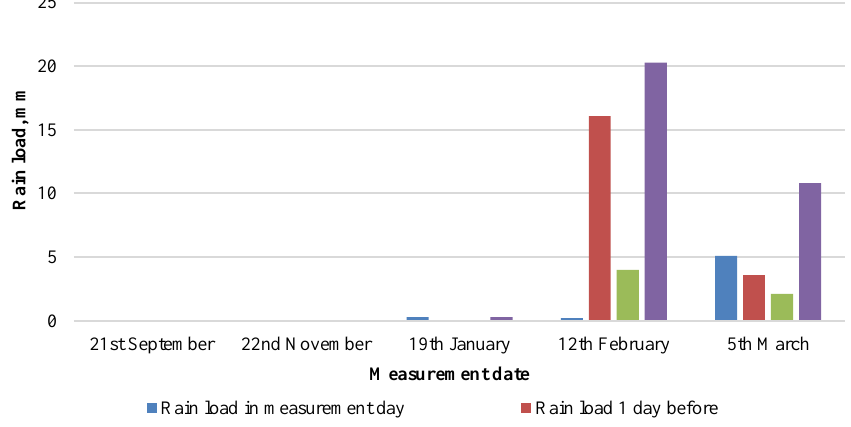
Fig. 10. Rain load of three days prior to the